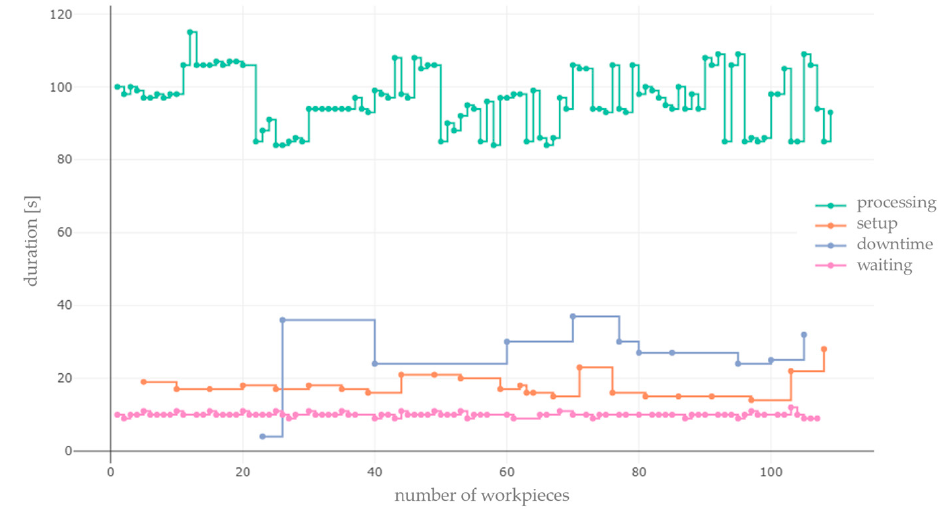
Figure 15. Time series graphs of the de fi ned states in test run one adjusted for extreme outliers. In addition to the weighted mean per state derived from the data adjusted for extreme outliers, the number of operations in which a regularity can be detected is included in the determination of the planned values for future production cycles. For the second test series, the application of the systematic approach results in the data in Figure 16 for production